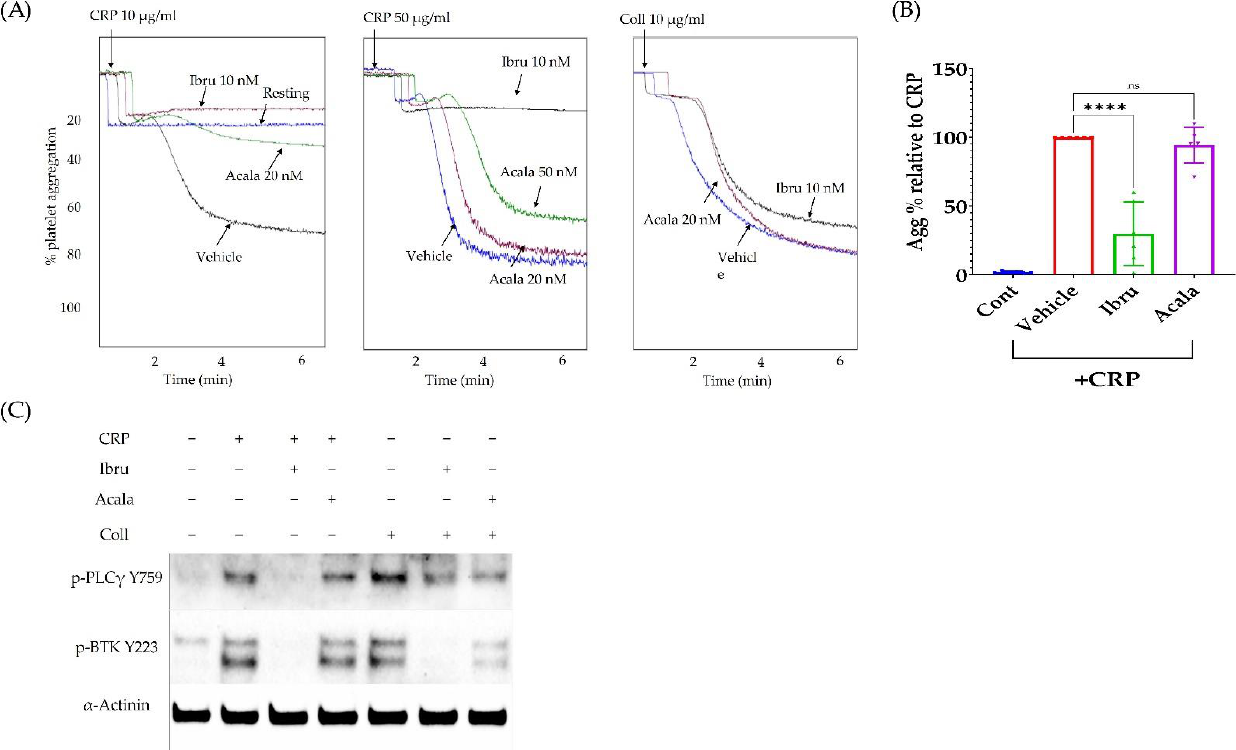
Figure 4. Ibrutinib (10 nM) inhibits CRP but not collagen-induced platelet aggregation . ( A ) Representative aggregation traces showing the effect of ibrutinib (10 nM) and acalabrutinib (20 nM) on CRP (10 and 50 ug/mL) and collagen (10 ug/mL)-induced platelet aggregation. Washed platelets were pre-incubated with the inhibitors for 60 min at 37 ◦ C before addition of the agonist. ( B ) Combined results of ibrutinib (10 nM) and acalabrutinib effect (20 nM) on CRP (50 µ g/mL)-induced platelet aggregation (n = 5). ( C ) The effect of ibrutinib and acalabrutinib on CRP (50 µ g/mL)-and collagen (10 µ g/mL) -induced activation of PLC γ 2 and BTK phosphorylation. Ibru: ibrutinb; Acala: acalabrutinib. **** p <0.0001; Insignificance is denoted by